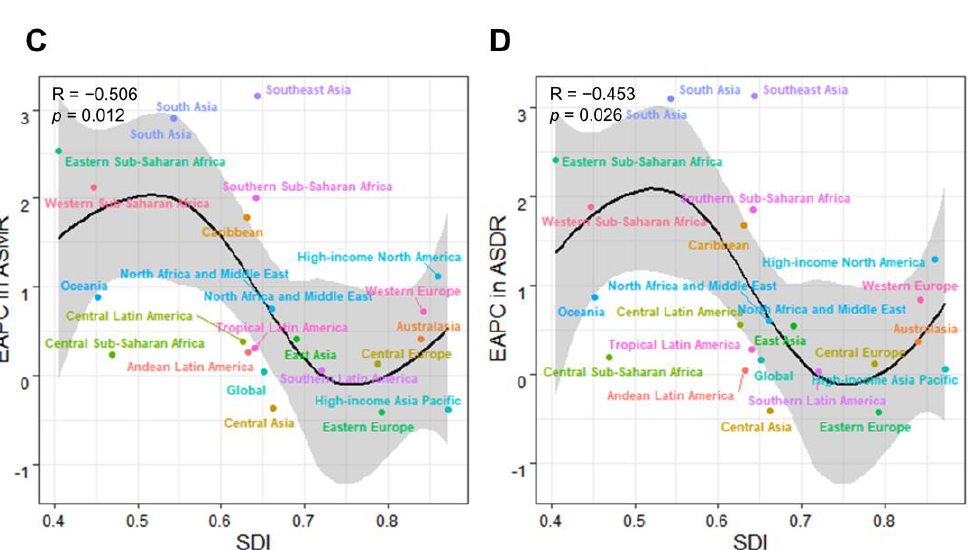
Figure 8. ( A ) Association of SDI levels with ASMR for uterine cancer attributable to high BMI in GBD regions from 1990 to 2019. ( B ) Association of SDI levels with ASDR for uterine cancer attributable to high BMI in GBD regions from 1990 to 2019. ( C ) Association of the GBD regional SDI with EAPC in ASMR in 2019. ( D ) Association of the GBD regional SDI with EAPC in ASDR in 2019. SDI, Socio-demographic Index; ASMR, Age-standardized mortality rate; ASDR, Age-standardized DALY rate; EAPC, Estimated annual percentage change.